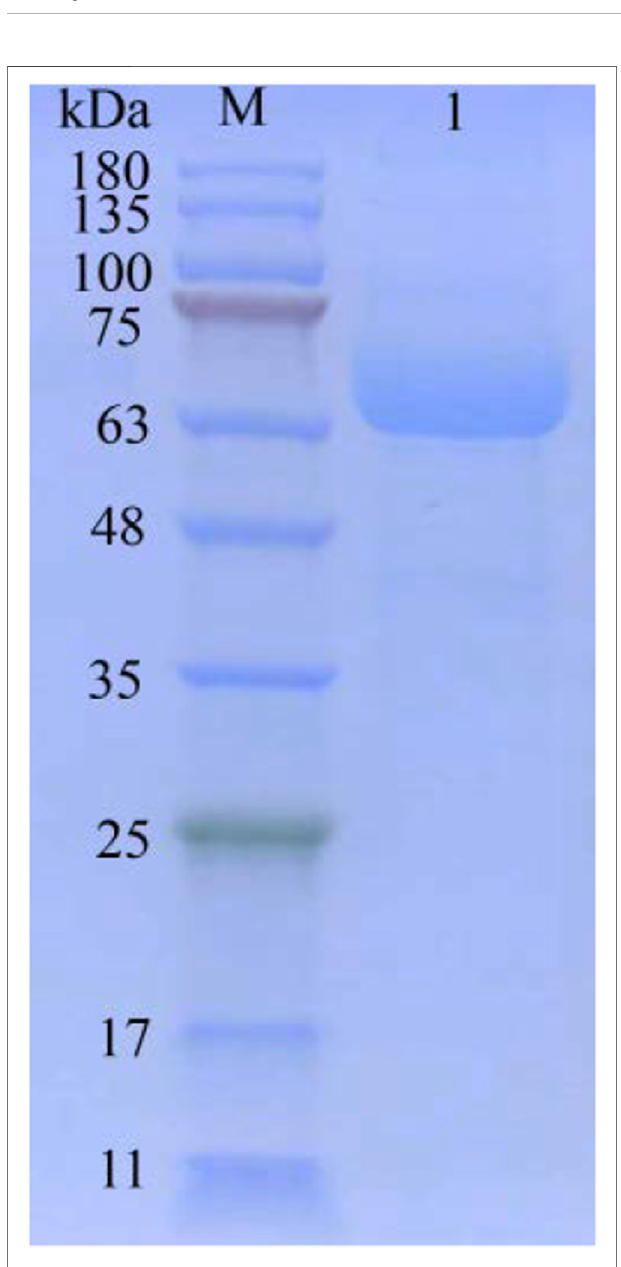
FIGURE 3 | SDS-PAGE of puri fi ed TanA. Lane 1: puri fi ed TanA; lane M: prestained protein ladder.